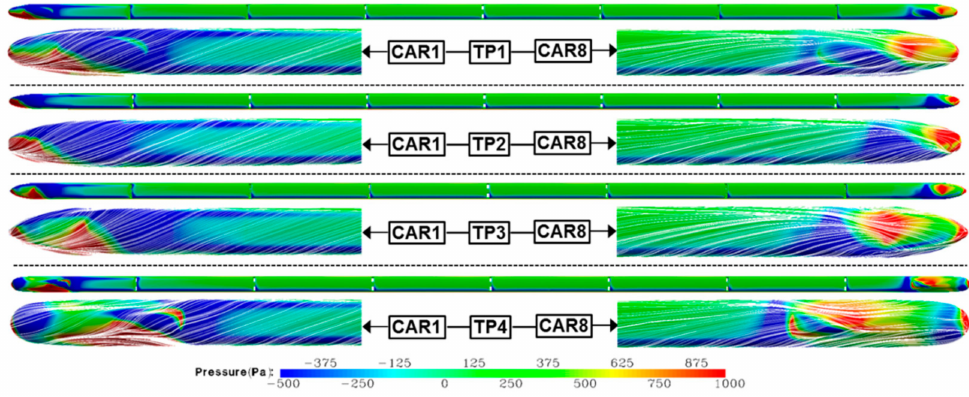
Figure 20. Time-averaged pressure contours and streamlines on the head and the